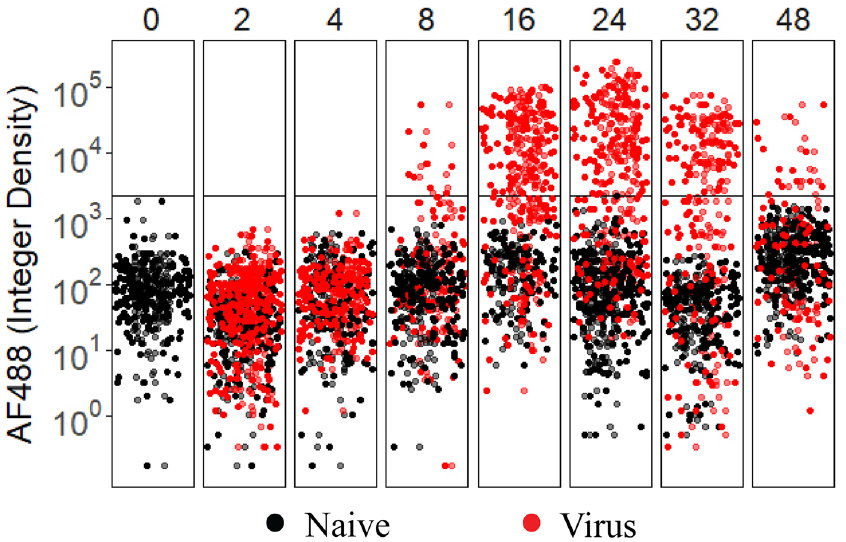
Figure 4. Relative dsRNA signal on a single-cell, normalized scale for naive (black) and HcRNAV-exposed (red) H. circularisquama cells sampled across time. Horizontal line indicates the highest background signal for naive cultures and serves as a conservative threshold for categorizing infection state. Variation in color intensity represents an artifact of the position_jitterdodge function of ggplot2 to improve visibility of closely clustered datapoints within each timepoint. (n = 72 to 226 cell observations per timepoint per treatment; 2278 total observations).